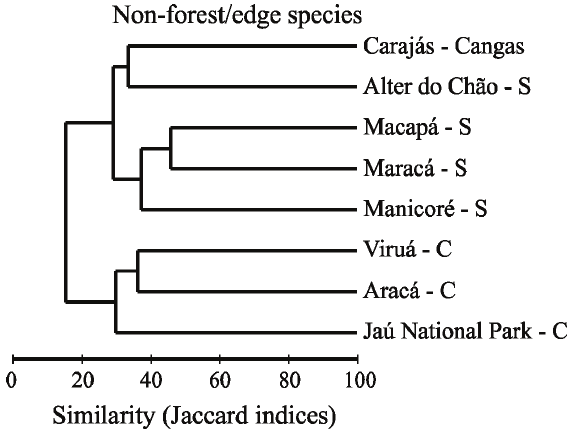
Figure 2 - Cluster analysis of bird inventories in open vegetation through the Brazilian Amazon including sites in white sand campinas (C), savanna vegetation (S) and Carajás cangas.